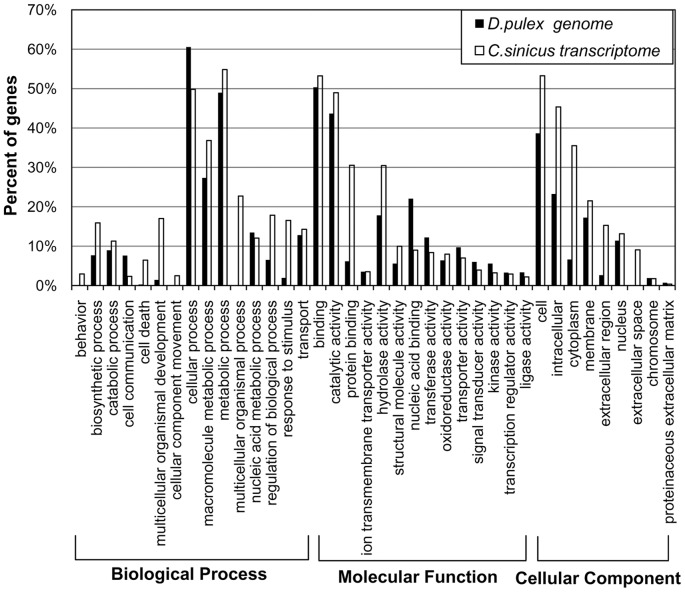
GO term distribution of BLAST hits from the C.
sinicus transcriptome.Selected GO categories are shown within the top-level divisions of Biological Process, Molecular Function, and Cellular Component. The relative percentages of genes falling into GO categories are comparable between our C. sinicus transcriptome (white) and the D. pulex genome (black).